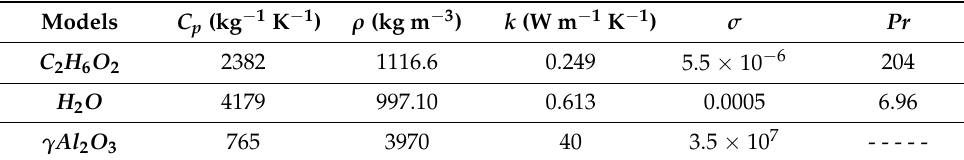
Table 1. Thermal and physical properties of base fluids and nanoparticles.